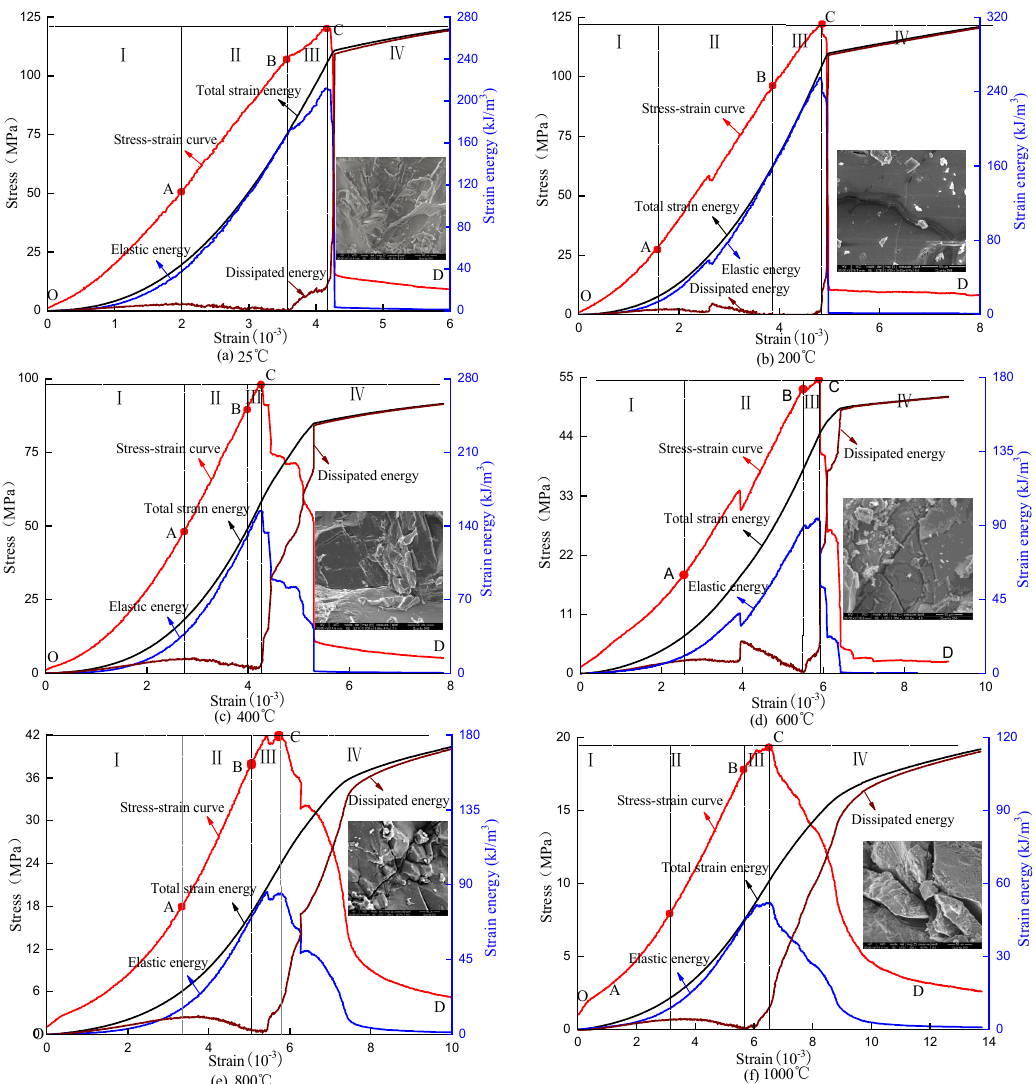
Figure 2. Stress strain and energy curves of rock under uniaxial compression at various tempera- tures.